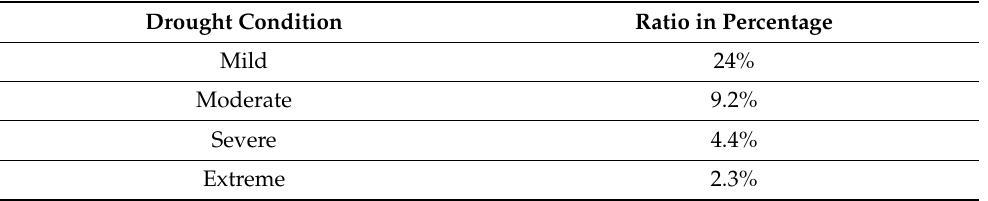
Table 1. Ratio of drought in Colorado